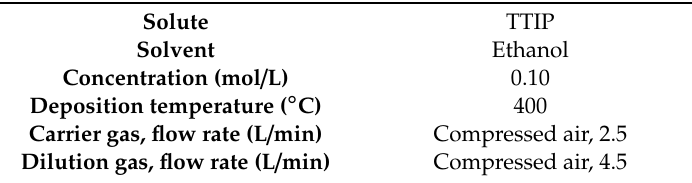
Table 1. Deposition condition of TiO 2 films.